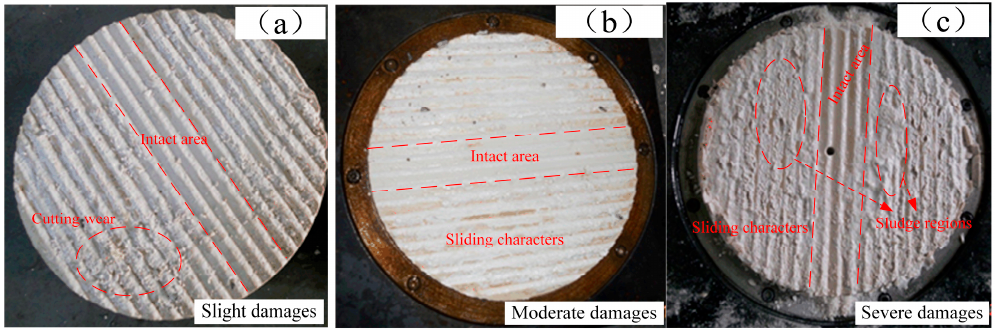
Figure 8. Photos of joint surface after the shear-flow coupled tests when normal stress is 2.5 MPa and joint roughness is 15°: ( a ) W p = 0.5 MPa; ( b ) W p = 1.0 MPa; ( c ) W p = 1.5 MPa.